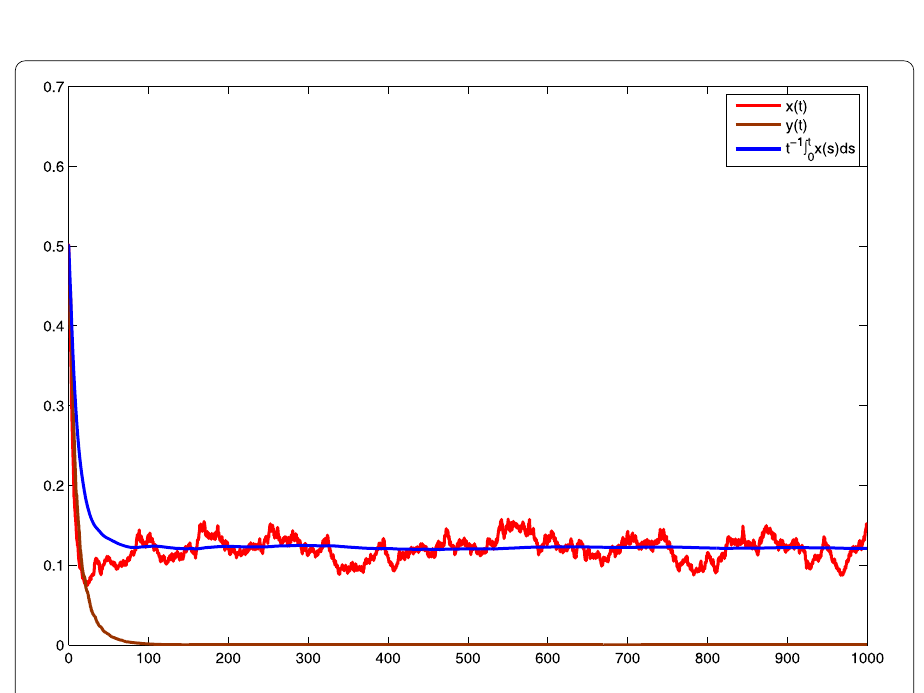
Figure 3 Solutions of model (3) with r 1 = 0.6, r 2 = 0.4, r 10 = 0.3, r 20 = 0.2, ξ 2 1 = 1.43, ξ 2 2 = 0.63, a = 0.4, c = 0.36, f = 0.25, h = 1. With α 1 = 0.65, α 2 =